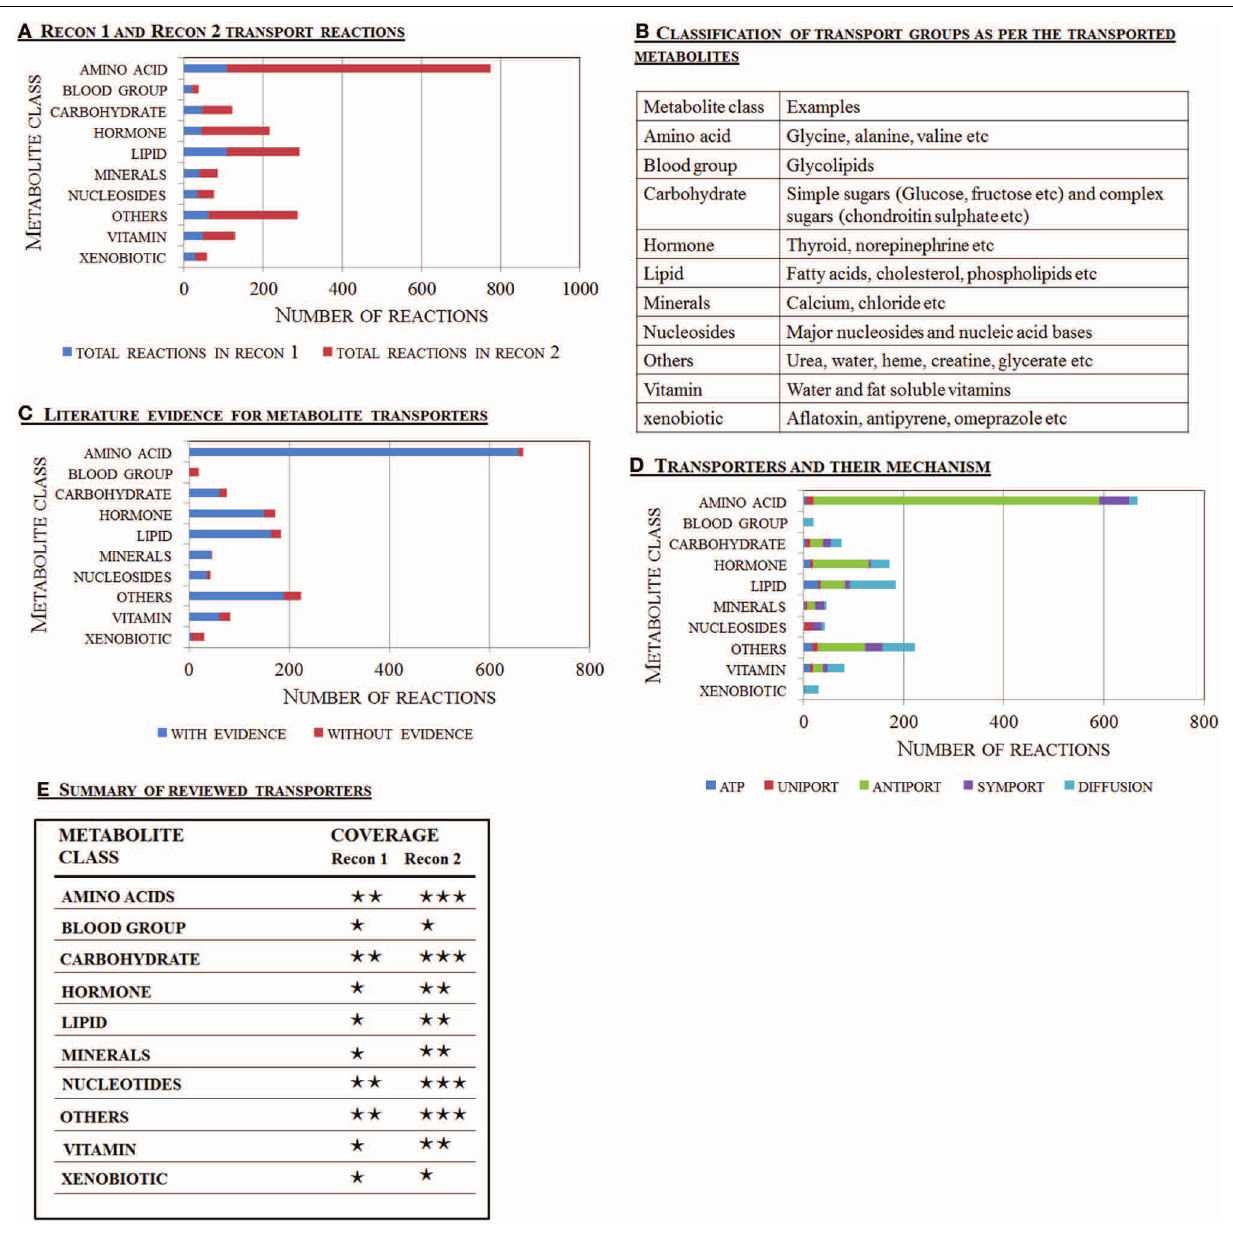
classes and their major transport mechanisms, as captured in Recon 2, are shown. The blood groups comprise the major glycolipids. (E) Comparison of the transport reactions present in Recon 1 and Recon 2. The increased information included and expanded the scope of Recon 2, over Recon 1, resulting in better transporter coverage for the amino acid, carbohydrate, and vitamin classes, while significant work is needed for the lipid class. The following symbols are used: (cid:2) (cid:2) (cid:2) , good coverage; (cid:2)(cid:2) , intermediate coverage; (cid:2) , needs significant